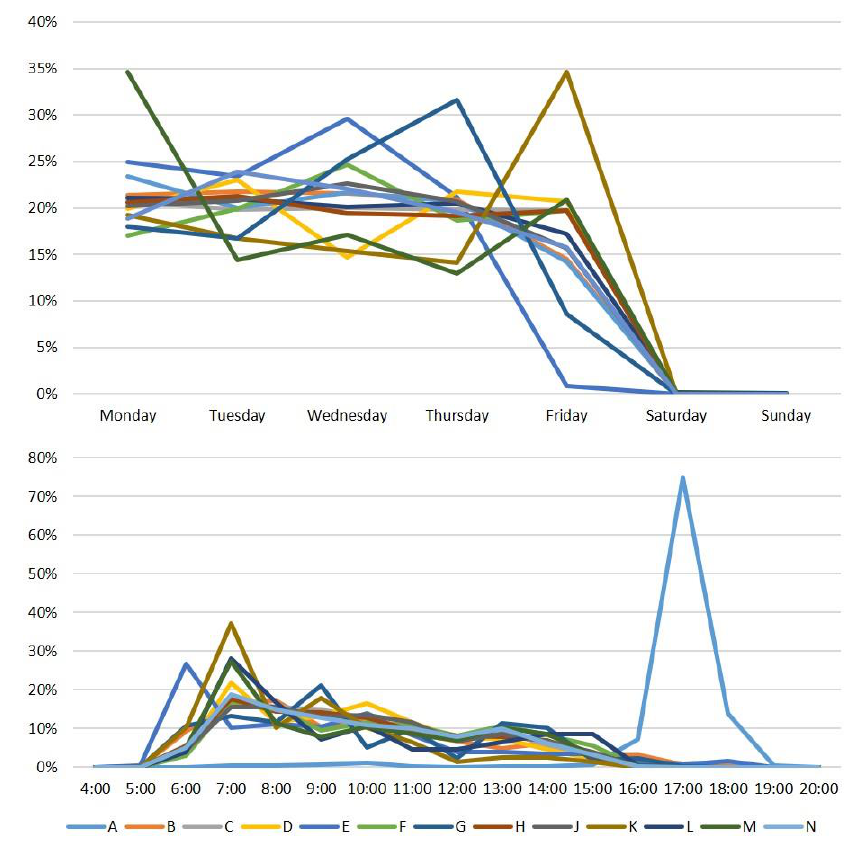
Figure 1. Weekdays and hourly distribution of transports. Table 2. Number of transports for the 13